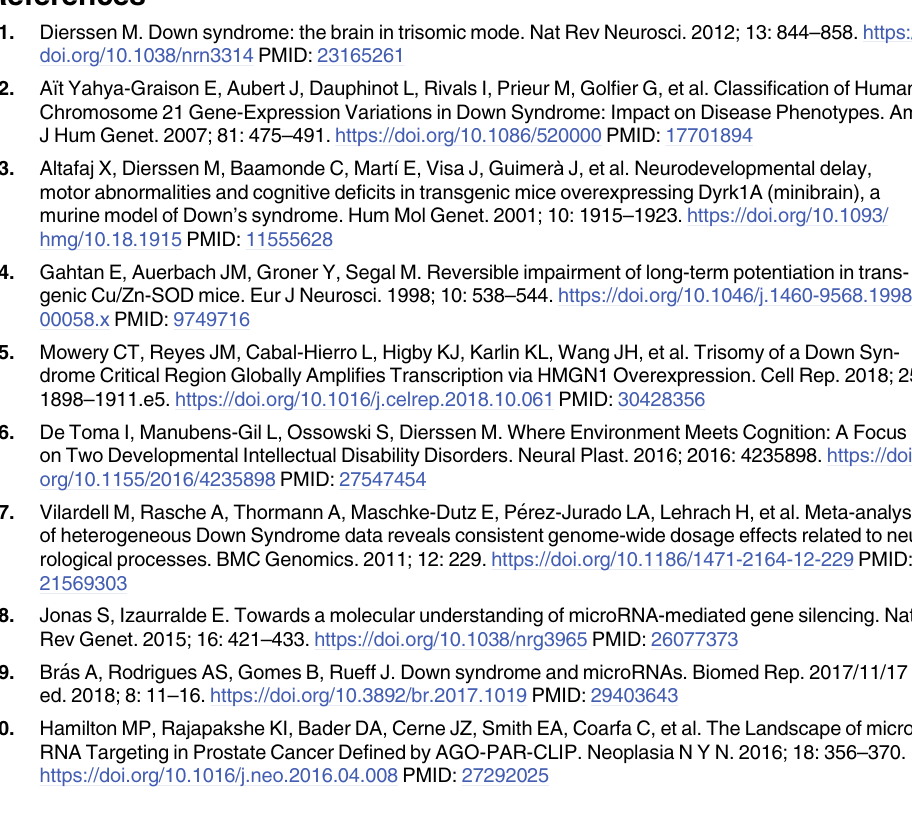
S1 Table. Information on the dataset used in this meta-analysis. S2 Table. Terms used in the